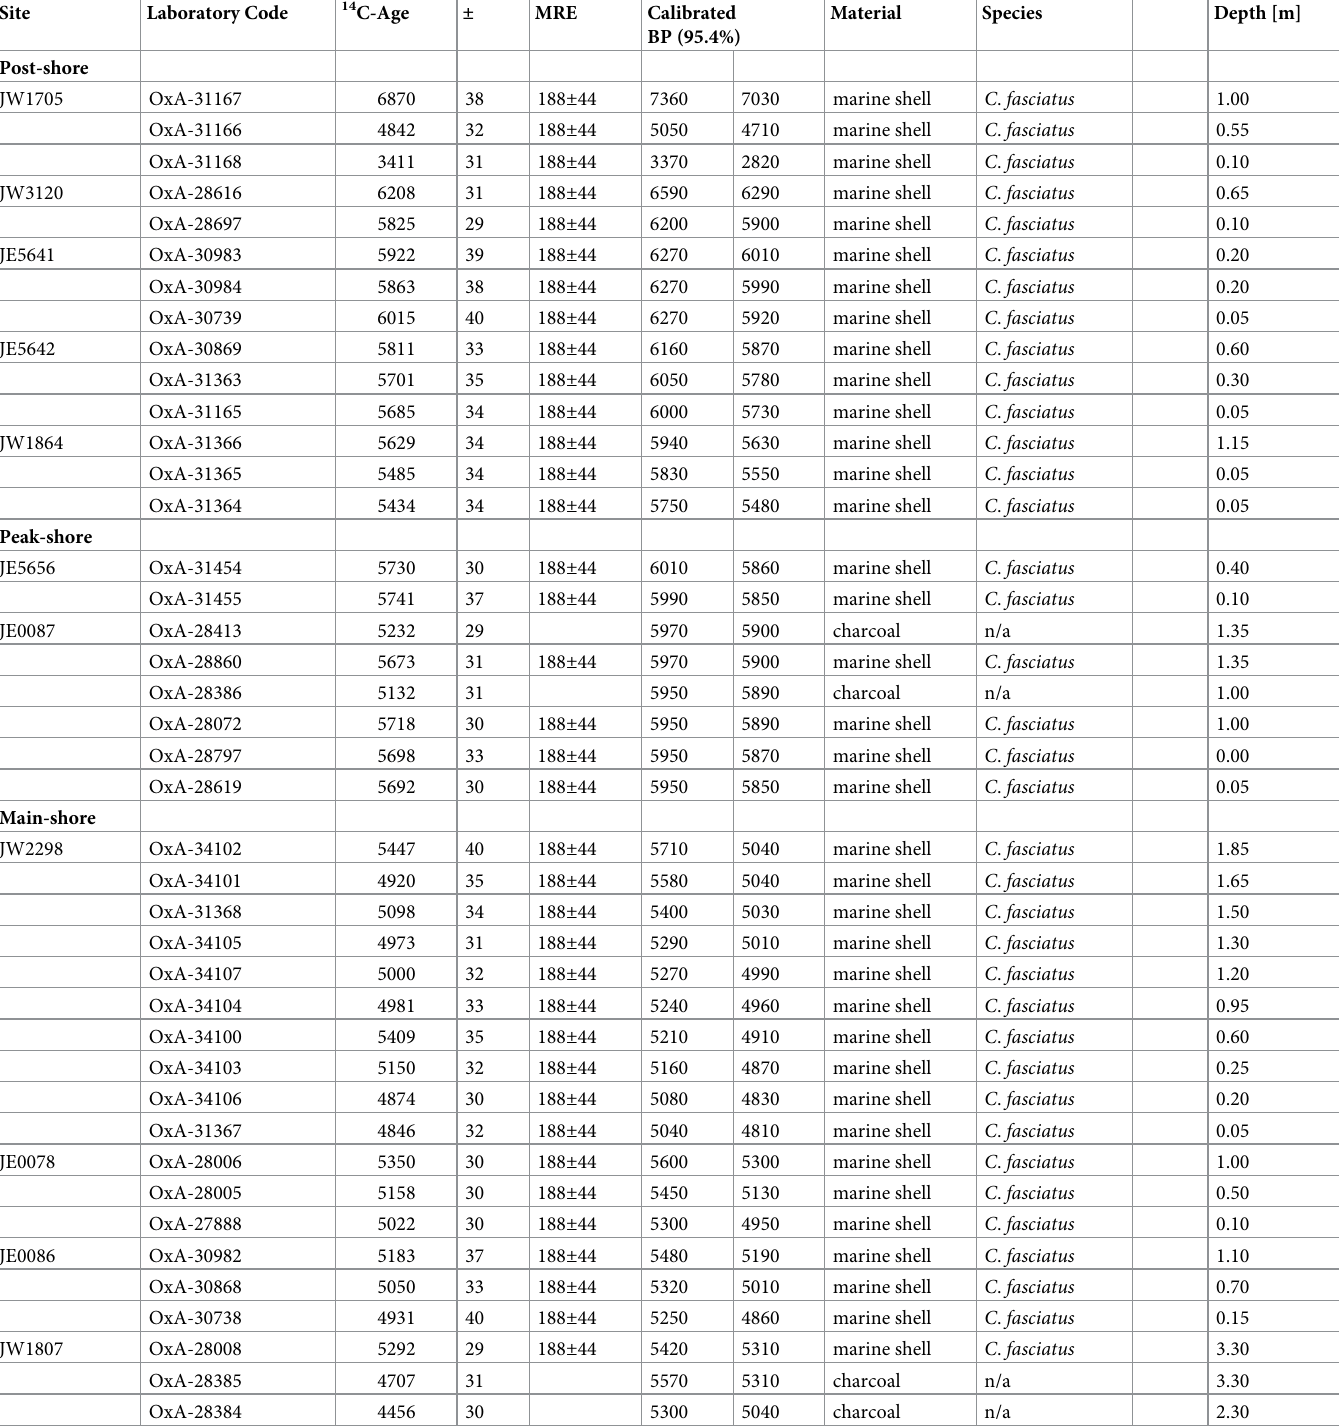
Table 1. Radiocarbon dates used for calculating the time depth and accumulation rates for all sites. Dates are shown as calibrated years BP (95.4% confidence interval) following Bronk Ramsey[69]. All dates are calibrated using Oxcal (version 4.3.2) and the corresponding curves for terrestrial (IntCal13) or marine (Marine13) samples as appropriate [70] with a local reservoir correction of 188 ± 44 years. Sites are grouped by type of location, within each location type in order of earliest deposits, and within each site by stratigraphic order from lowest to highest